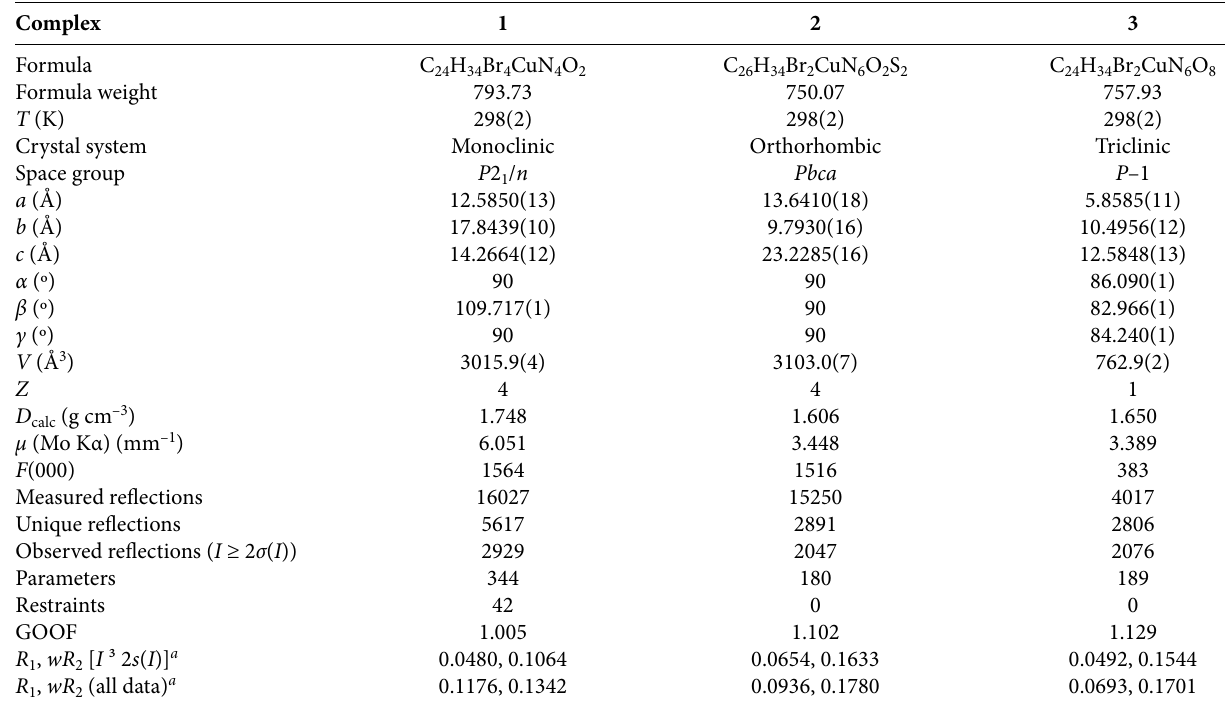
Table 1. Crystallographic and refinement data for the complexes